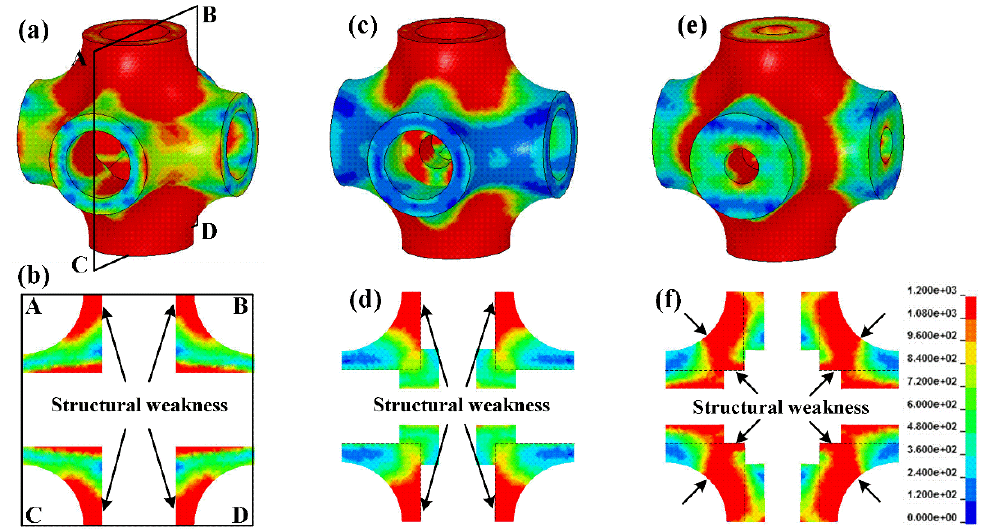
Figure 4. Stress distribution and sectional view ABCD at the strain of 3%: ( a , b ) the cell of specimen HT, ( c , d ) the cell of specimen HTSJ, and ( e , f ) the cell of specimen HTSW.